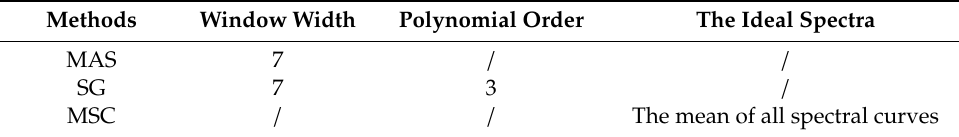
Table 2. Parameter settings for di ff erent preprocessing